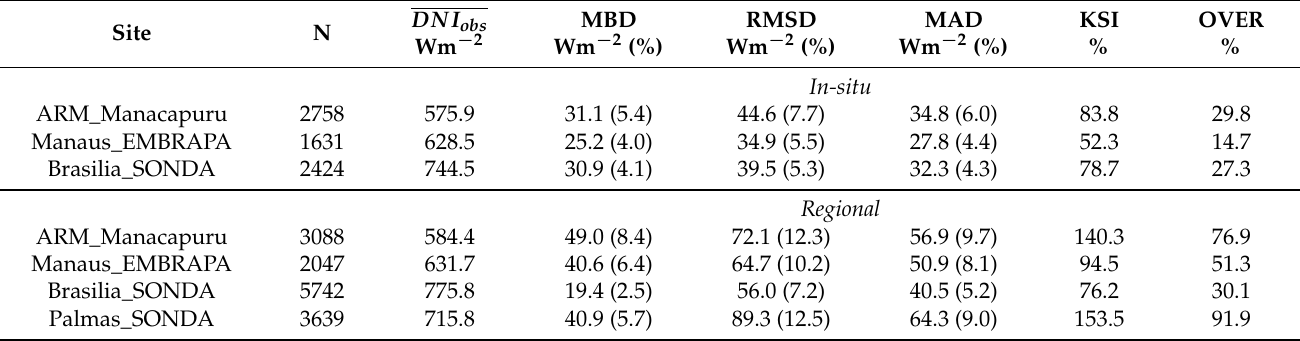
Figure 8. Scatter plot for DNI between observational data and BRASIL-SR (obtained using δ - Eddington scaling) for regional experiment (grey) and in-situ experiment (red) for the four ground measurement sites. Table 4. Benchmark comparisons between clear-sky DNI observations and BRASIL-SR estimations (experiments in-situ and regional ) using δ -Eddington